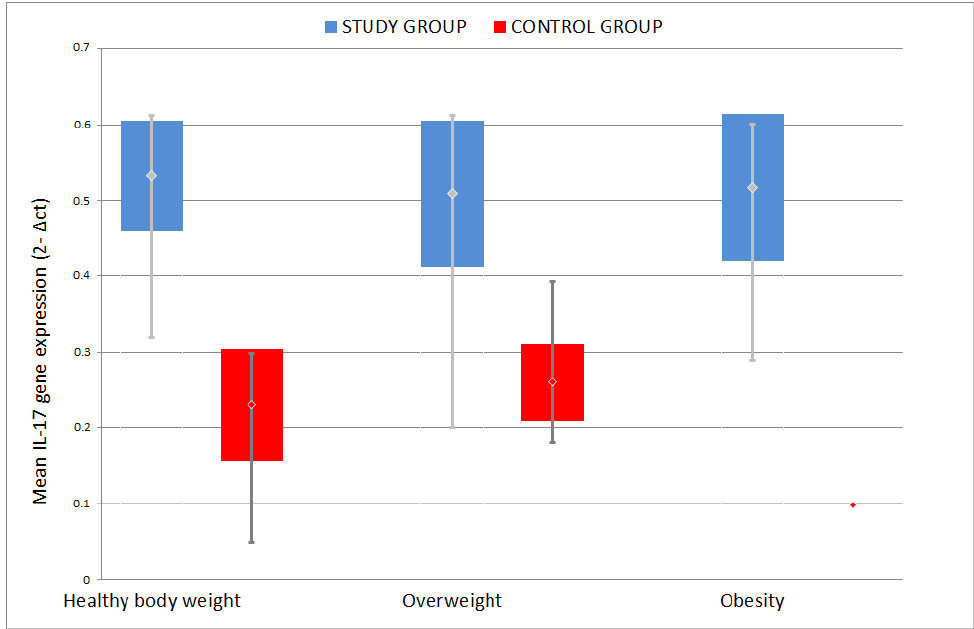
ff erent weight groups.